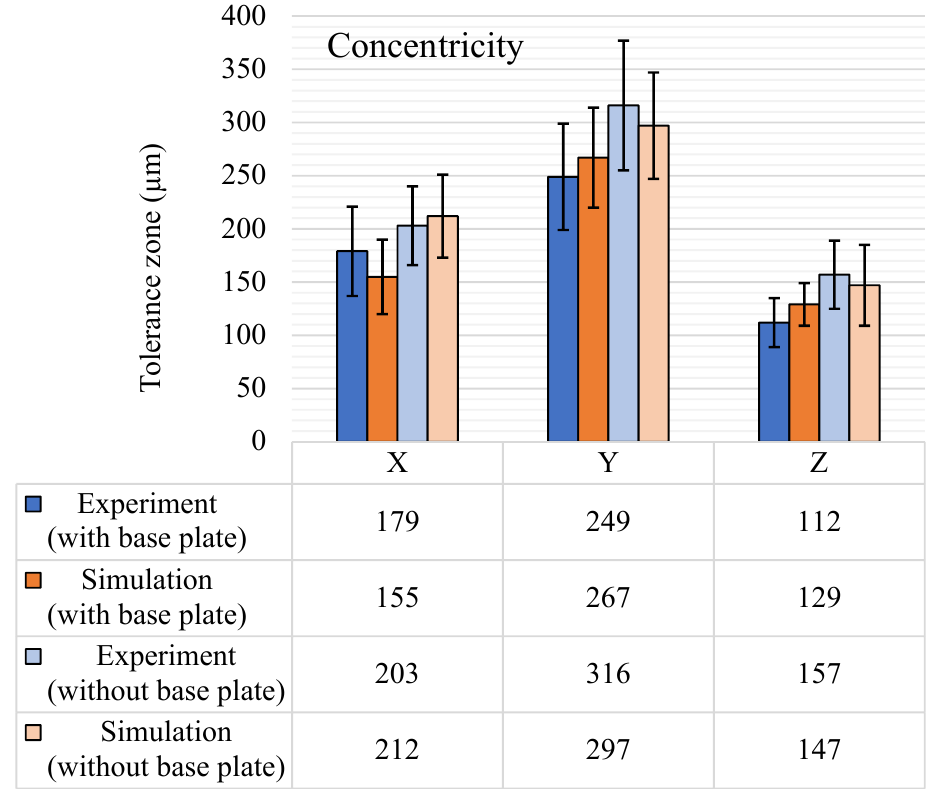
Figure 16. Concentricity (µm) tolerance results, with and without the base plate.